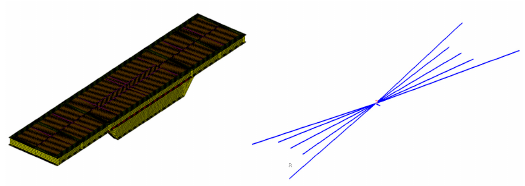
Figure 17. Di ff erent models of the wagon frame. Figure 17. Different models of the wagon frame. F igure 18. View of the test wagon.